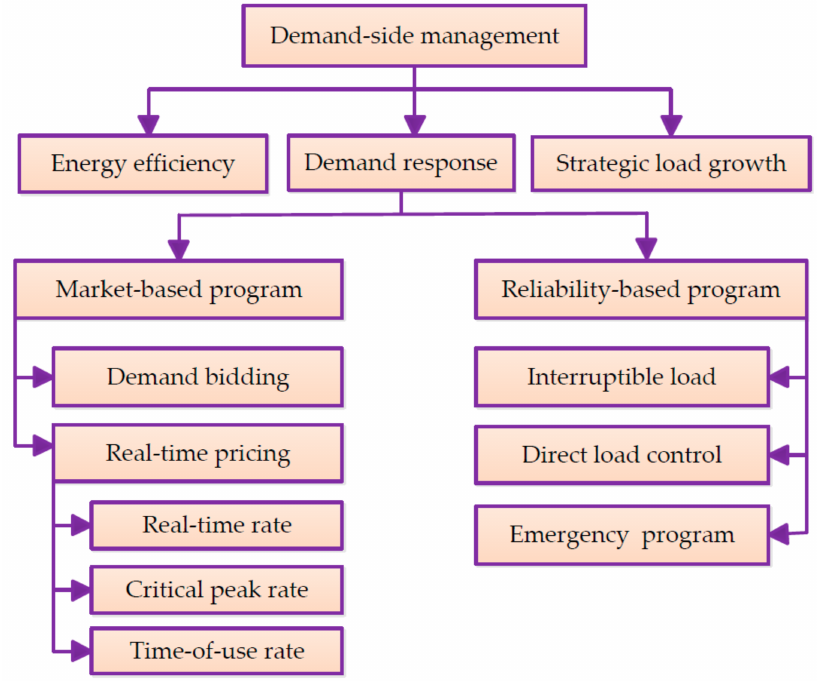
Figure 1. Various DSM (Demand-side management)